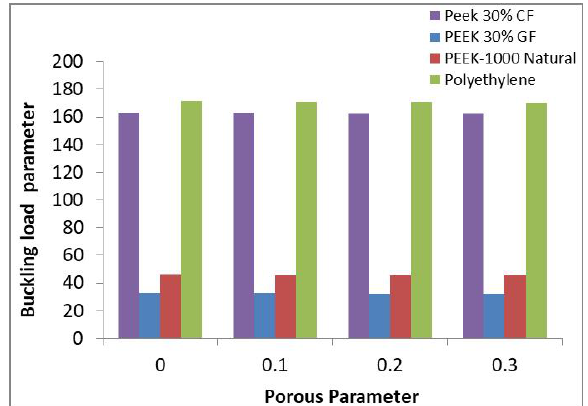
Fig. 7. Buckling load parameter results for various porous metal types at k = 0.2, ( a / h =50, a / b =1), and skins height 2